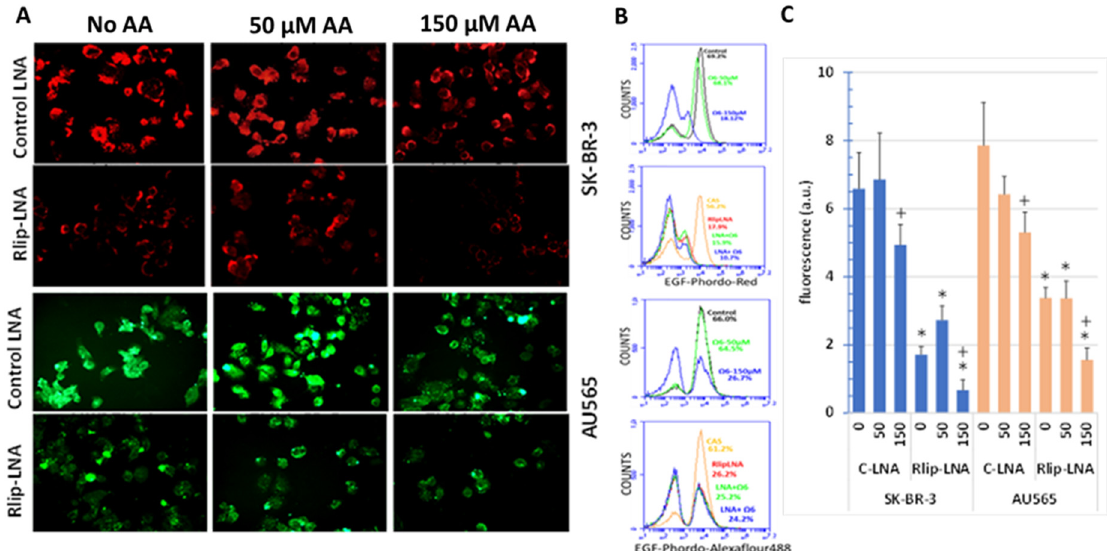
Figure 11. Effect of AA treatment on EGF binding and internalization after Rlip depletion: cells were transfected with Rlip-LNA or control LNA antisense (CAS) and treated with AA as described in Materials and Methods. ( A ) Representative images from three separate experiments show EGF-pHrodo-red (SK-BR-3 cells) and EGF-pHrodo-Alexa Fluor 488-green (AU565 cells) for EGF internalization after AA treatments, with and without Rlip depletion. All images are at 400 × maginification. ( B ) Cells were treated identically to those in panel ( A ) and analyzed by flow cytometry. ( C ) Quantitative analysis of fluorescence intensity is the mean ± SD of three independent experiments (+ p < 0.05 vs. no C-LNA, * p < 0.001 vs. respective C-LNA concentra- tions).